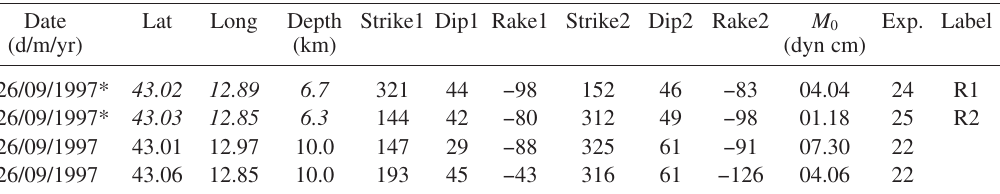
Table II. RCMT Catalog. Parameters (strike, dip, and rake of the first and second nodal planes) of moment ten- sors selected for the study area from the Euro-Mediterranean RCMT Catalog (Pondrelli et al. , 2002, 2004). The label R represents RCMT, as described in the text; D represents deep. Events with * represent hypocentral loca- tions sourced from: C1 – Deschamps et al. (1984); C2 – Collettini et al. (2003); C3 – Ciaccio et al. (2005); R1, R2, R4 and R5 – Chiaraluce et al. (2003); R7 and RN1 – Castello et al. (2005); R3 and D2 – present study; F10 – Di Luccio et al.